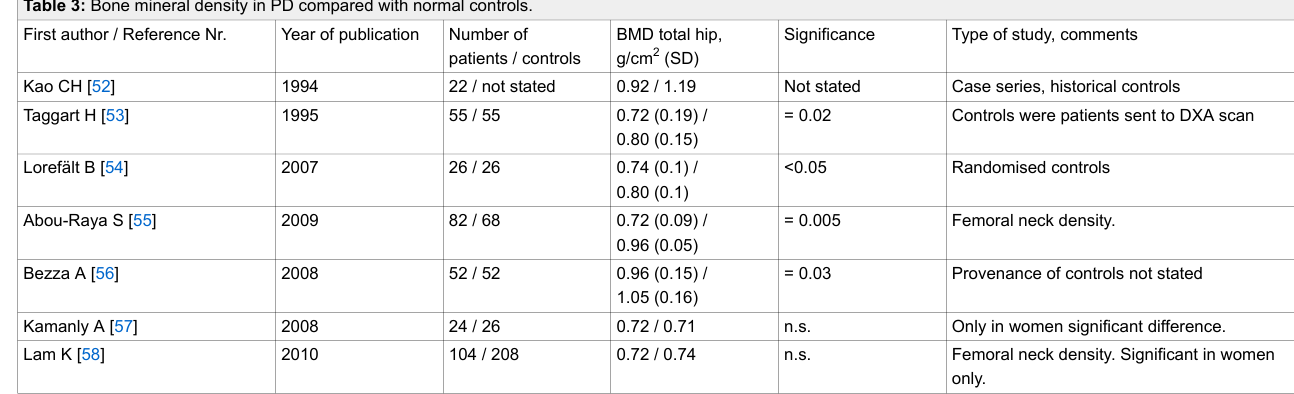
Table 3: Bone mineral density in PD compared with normal